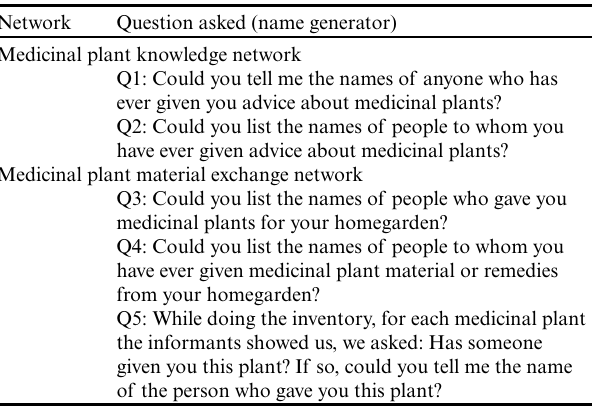
Table 1. Name generating questions used to elicit information on knowledge and medicinal plant material exchange social networks in homegardens in two Tsimane’